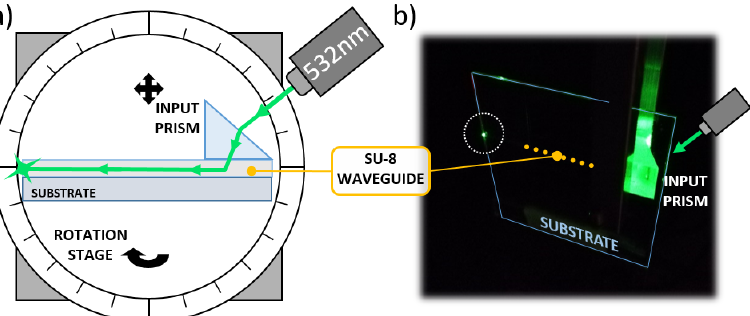
Figure 7. Optical waveguide characterization. ( a ) Characterization setup. ( b ) Picture taken during the optical tests.